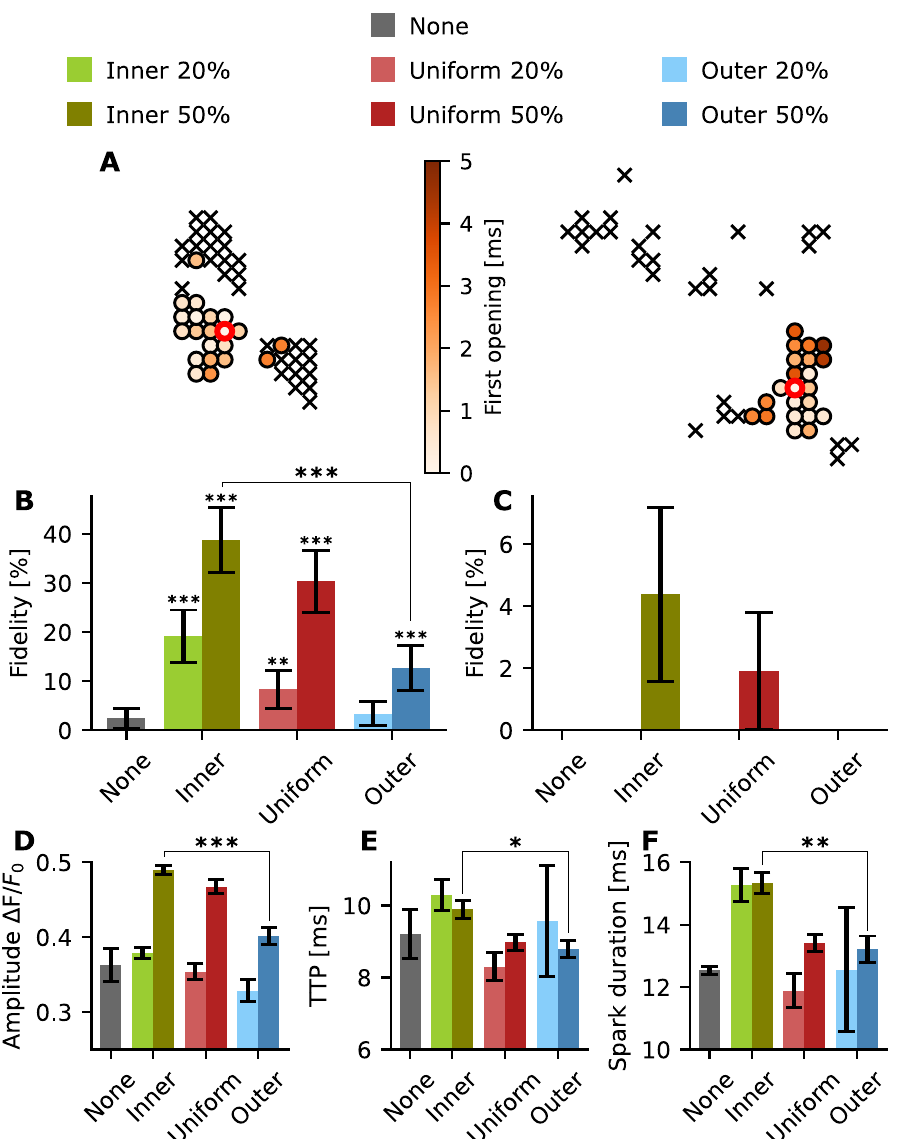
Fig 8. Spark properties for disrupted geometries G4 and G5. For each setup 200 single simulations were conducted. Green: inner; red: uniform; blue: outer; gray: no phosphorylation. Light colours: 20% phosphorylation; dark colours: 50% phosphorylation. (A) Activation map with the first opening time of each RyR for a representative simulation for uniform phosphorylation, G4 (left) and G5 (right). ‘x’ indicates that the RyR did not open during the simulation. red circle: initial open RyR. (B) Spark fidelity for none, inner, uniform, and outer phosphorylation in G4. The black bars indicate the 95% Agresti-Coull confidence interval. (C) Spark fidelity for none, inner, uniform, and outer phosphorylation in G5. The black bars indicate the 95% Agresti-Coull confidence interval. (D) Amplitude (mean ± standard error) for none, inner, uniform, and outer phosphorylation in G4 (no phosphorylation n = 3, inner 20% n = 37, inner 50% n = 77, uniform 20% n = 15, uniform 50% n = 60, outer 20% n = 5, outer 50% n = 24). (E) TTP (mean ± standard error) for none, inner, uniform, and outer phosphorylation in G4. (F) Spark duration (mean ± standard error) for none, inner, uniform, and outer phosphorylation in G4. � =p < 0.05, �� =p < 0.01 and ��� =p < 0.001. The p values were calculated with respect to the non phosphorylated case using a t-test, except for the fidelity p value which was calculated from Fisher’s exact test (due to binary